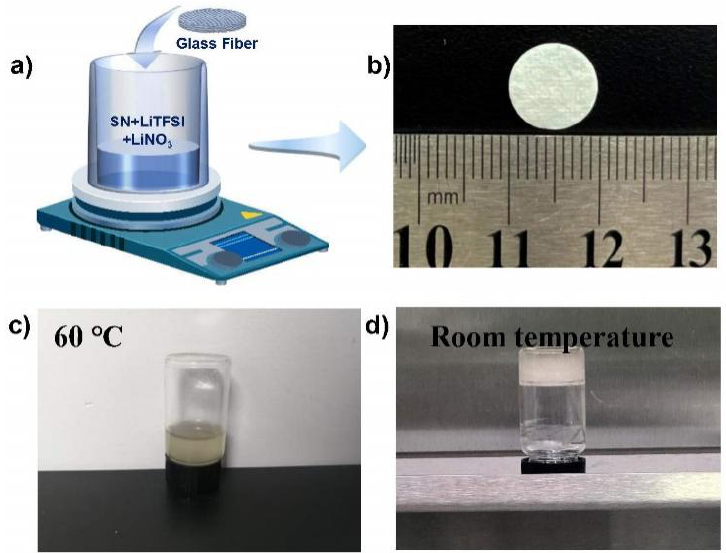
Figure 1. ( a ) Schematic diagram of the preparation of SPCE film. ( b ) Photo image of SPCE film. Photo images of the state of SPCE solution at ( c ) 60 °C and ( d ) room temperature.